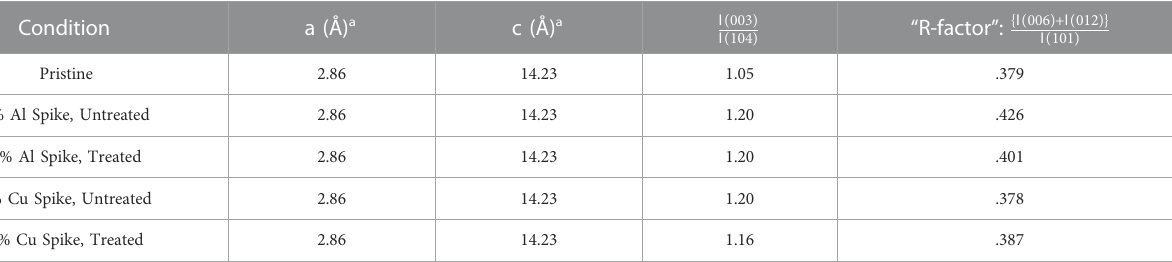
TABLE 1 Rietveld re fi nement of samples shown in Figure 9. a